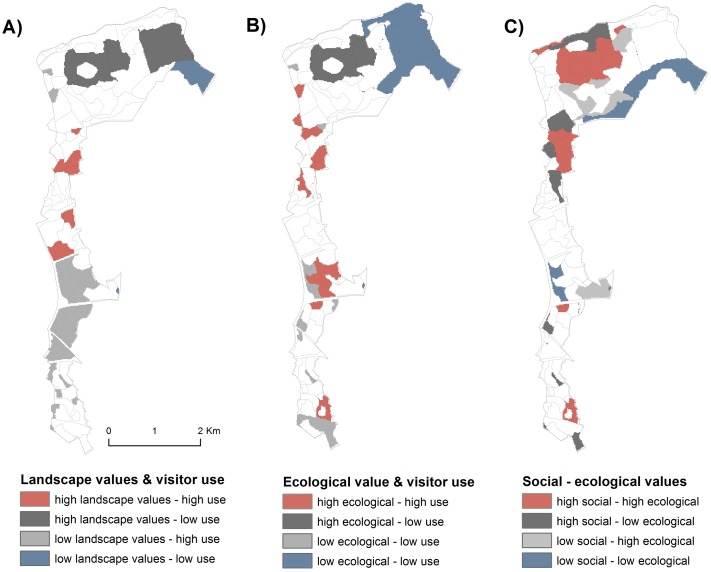
Hot/Coldspot pairwise overlays.(A) Multiple landscape values and visitor use, (B) Combined ecological value and visitor use and (C) Combined social value and combined ecological value. High and low areas represent top and bottom 33% of values for each metric respectively.